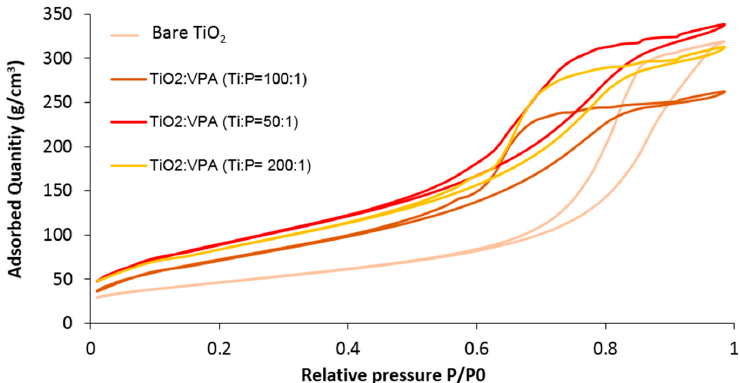
Figure 1. N 2 adsorption-desorption isotherms for bareTiO 2 , and hybrid samples (TiO 2 ) x (VPA) with x = 50, 100 and 200.